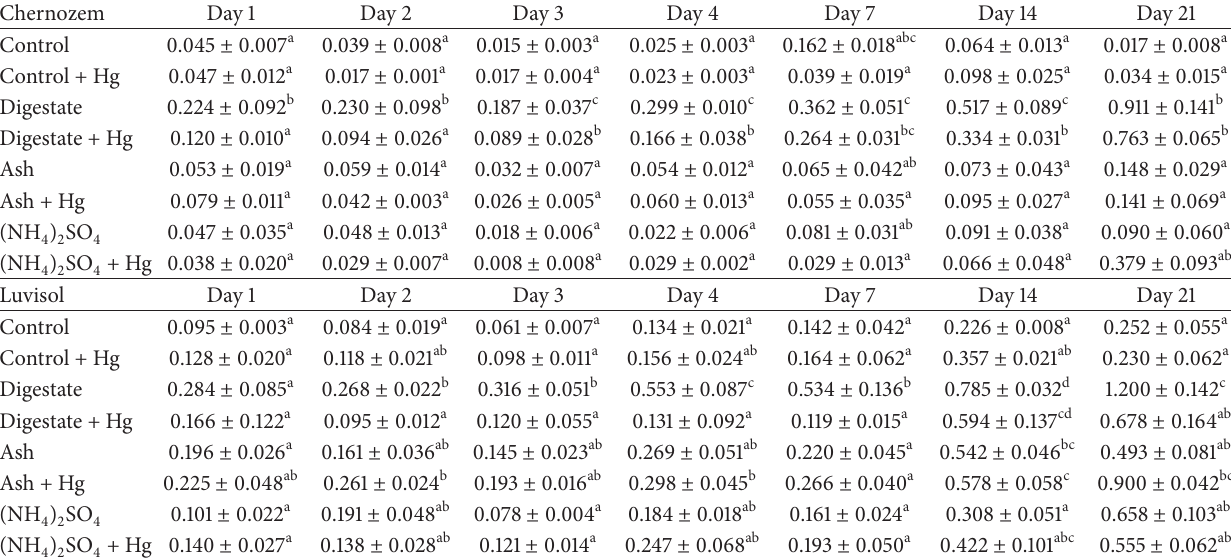
Table 6: The concentrations of Cu extractable with 0.11molL − 1 acetic acid within the incubation experiment (mg ⋅ kg − 1 ); the averages marked by the same letter did not significantly differ at 𝑃 < 0.05 within individual columns; data are presented as mean ± standard deviation ( 𝑛 = 3